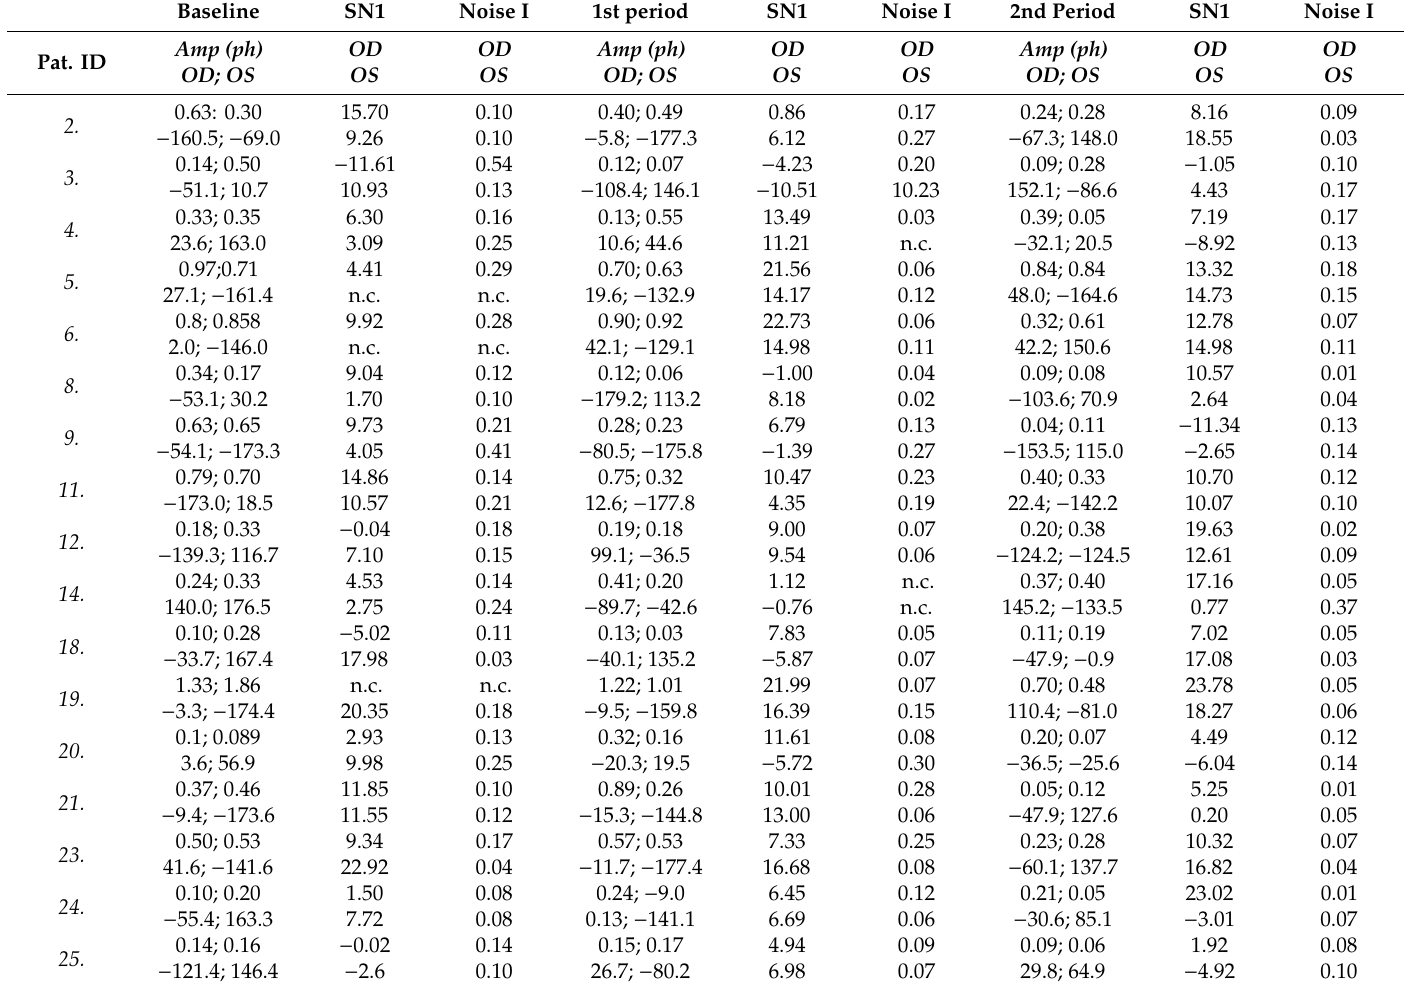
Table 2. Electrophysiological Data of Patients. Data not classified